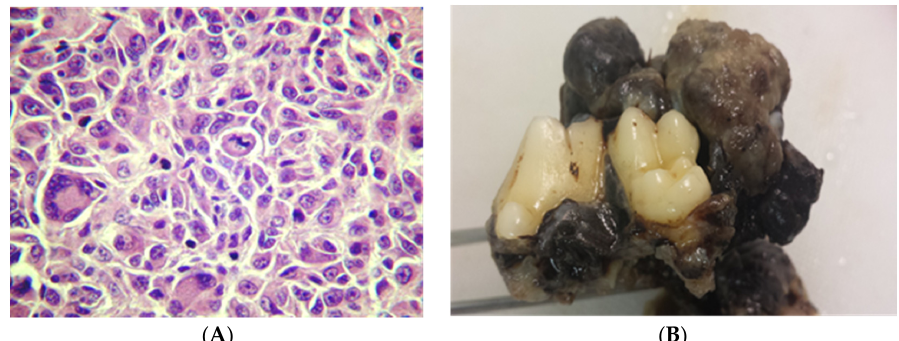
Figure 2. Photomicrograph of the most common histopathology type of malignant melanoma (epithelioid), showing formation of cell nests, with the presence of multinucleated giant cells and atypical mitotic figures, HE, Objective 40 × ( A ). Canine oral malignant melanoma, pigmented, exophytic mass protruding from the gingiva ( B ). Formalin-fixed tissue. Photographs are courtesy of Professor Dr. José Guilherme Xavier.